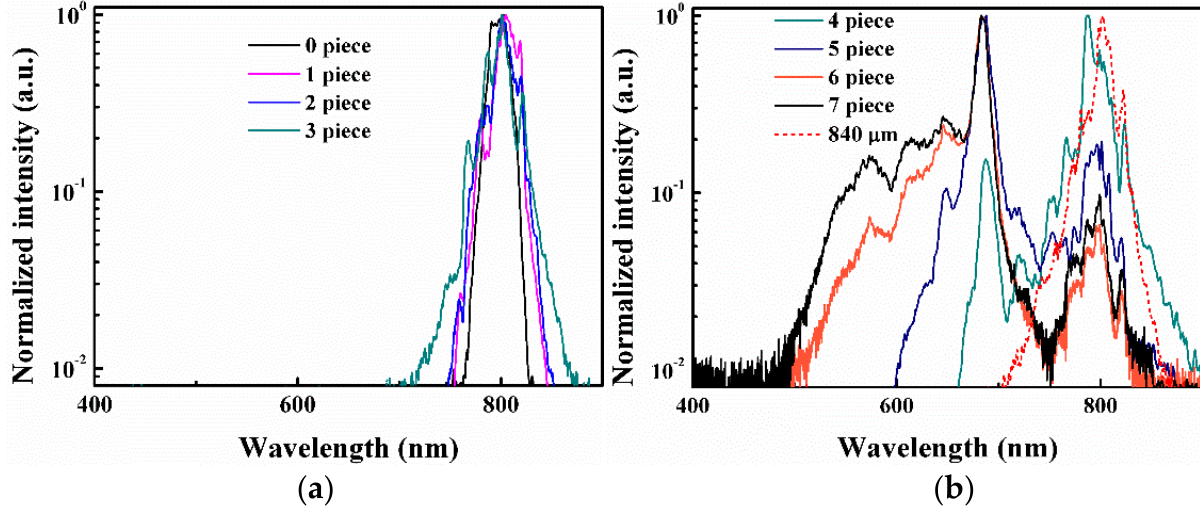
Figure 2. Spectra passing through the fused silica plates. The “0 piece” indicates fundamental spectrum. Red dotted line represents the spectrum generated from the single 840 µm plate. Each spectrum was normalized by its maximum value.